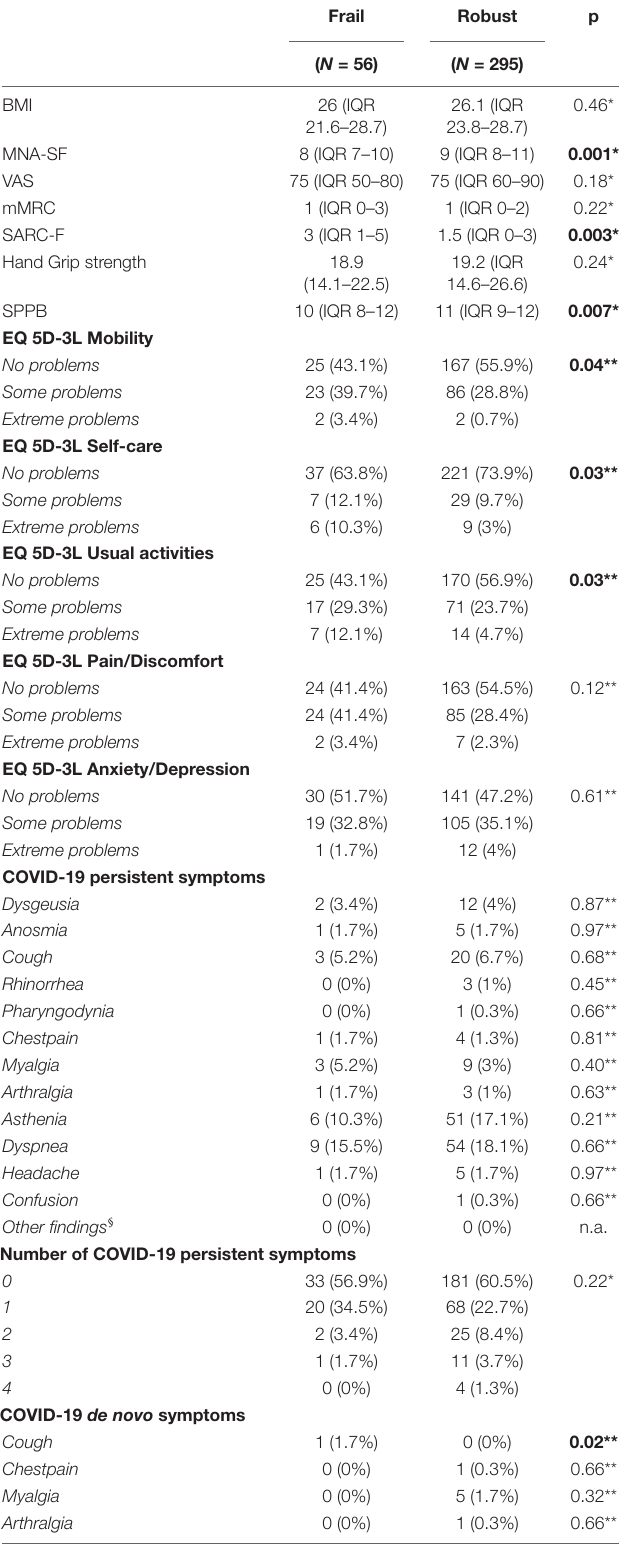
TABLE 2 | Nutritional and muscle characteristics, quality of life, and COVID-19 manifestations at the 1-month follow-up visits. Frail